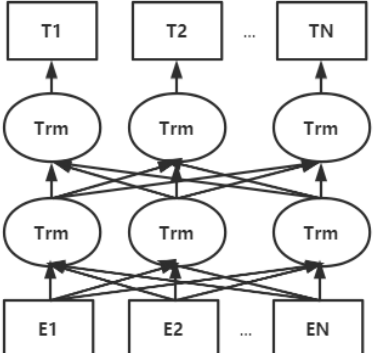
Figure 3. Figure from <Bert: Pre-training of deep bidirectional transformers for language understanding>. BERT’s (bidirectional encoder representation from transformers) model architectures. BERT uses a bidirectional transformer. BERT’s representations are jointly conditioned on both the left and right context in all layers [36].